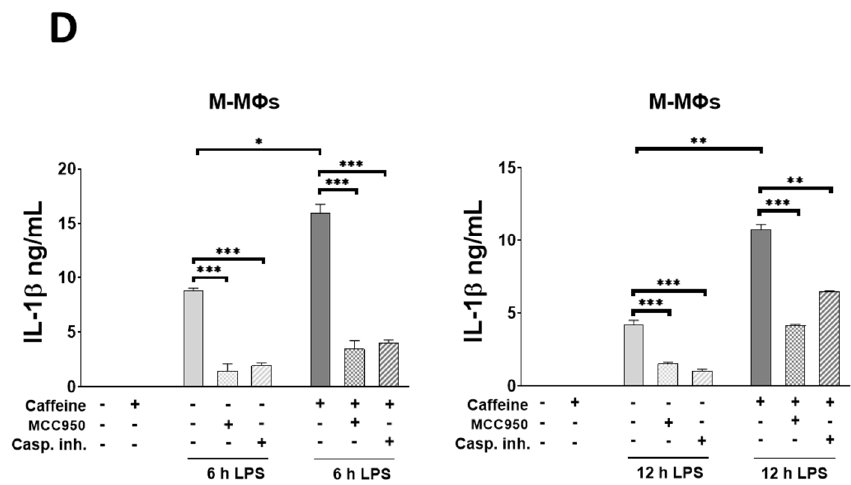
Figure 3. Effects of caffeine pre-treatment on the expression and activation of NLRP3 inflammasome in M Φ s. Cells were pre-treated with caffeine (0.3–1 mM) for 1 h, then stimulated with LPS (100 ng/mL) for the indicated time. Representative immunoblots of ASC, pro-caspase-1, NLRP3, pro-IL-1 β , and Caspas-1 p20 obtained from cell lysates of GM-M Φ s ( A ) and M-M Φ s ( B ). Bar graphs represent the relative protein expression of pro-IL-1 β and NLRP3 and Caspas-1 p20 determined by densitometry ( B ). The relative gene expression of pro-IL-1 β and NLRP3 of LPS-activated M-M Φ s ( C ). M-M Φ s were pre-treated with caspase-1 inhibitor (Z-YVAD-FMK, 20 mM) prior to LPS priming, or MCC950 (1 µ M) 1 h before ATP treatment ( D ). Cyclophilin (Cyclo) was used as reference gene to normalize the gene expression. All results are shown as means ± SEM. (* p < 0.05, ** p < 0.01, *** p < 0.001).